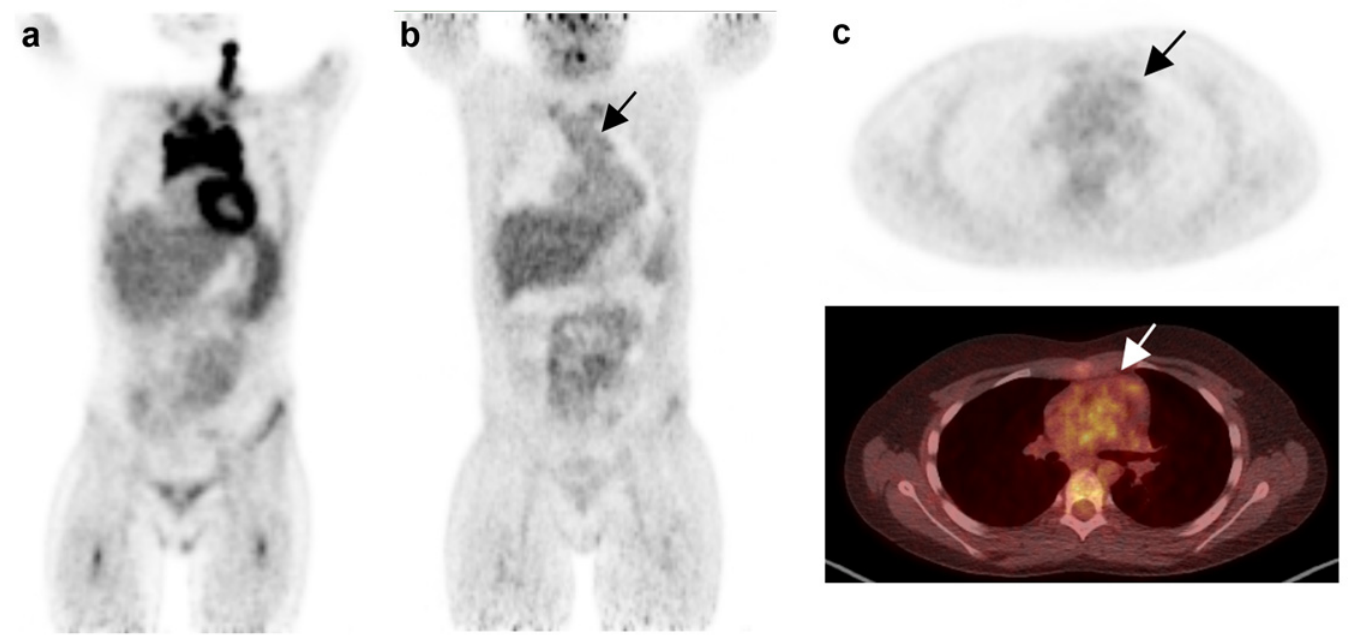
Fig 2. Residual uptake in the mediastinum vs. thymus. Case 12: a) Lymphoma involvement of the upper and middle mediastinum including the thymus before treatment. b) and c) very slightly enhanced uptake as compared to the mediastinum after two cycles ChT. The interpretation might be complicated by the difficult decision whether this finding implies residual tumor uptake or physiological but inhomogeneous uptake in the thymus. Deauville score of the readers R1-5, respectively: 1-1-3-3-3. Courtesy Dept. Nuclear Medicine, Blackrock Clinic, Dublin, Ireland.